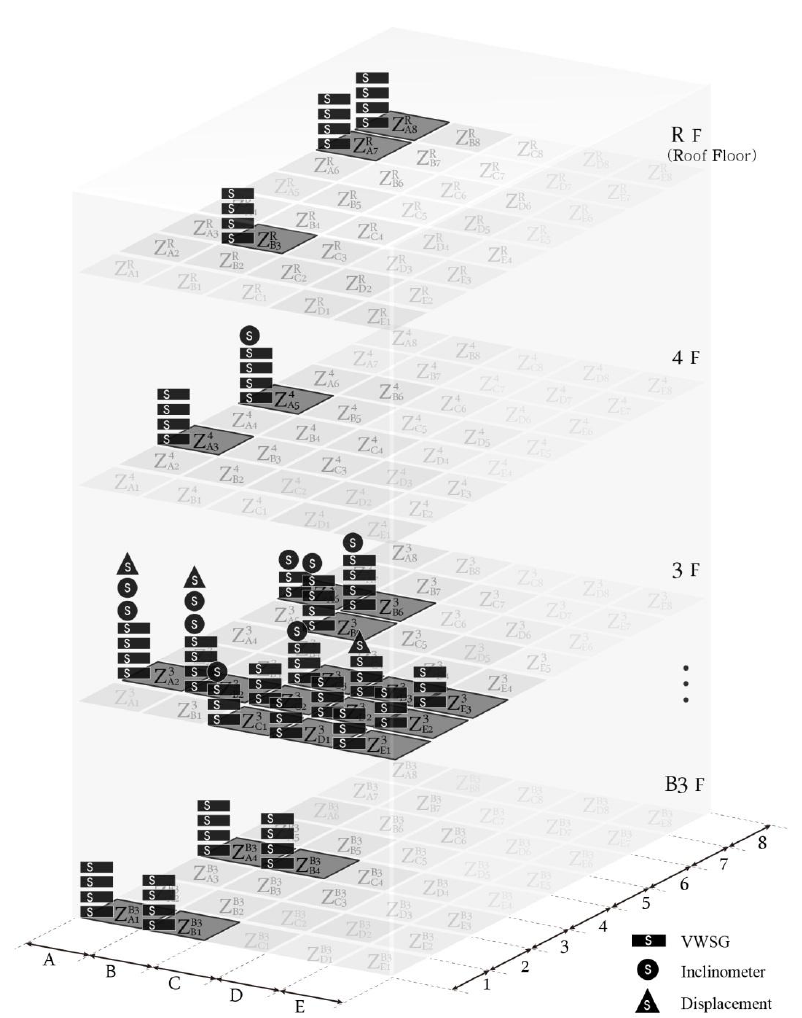
Figure 9. Conceptual 3D zoning diagram for